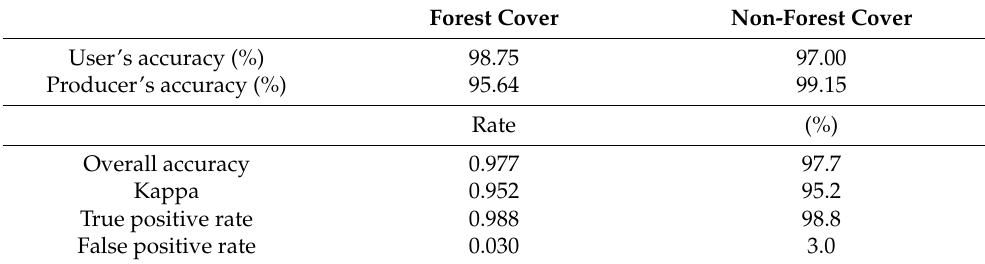
Table 2. Accuracy assessment for the forest and non-forest cover classification.